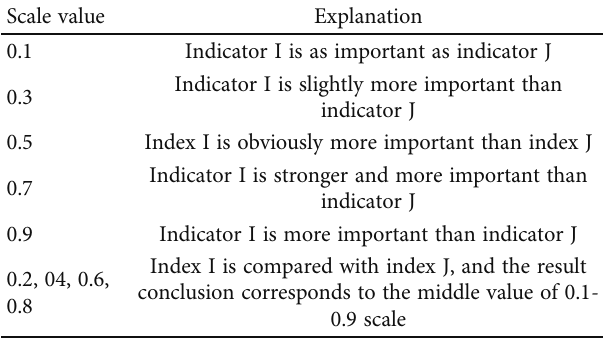
Table 2: Nine-scale table of 0.1 ~